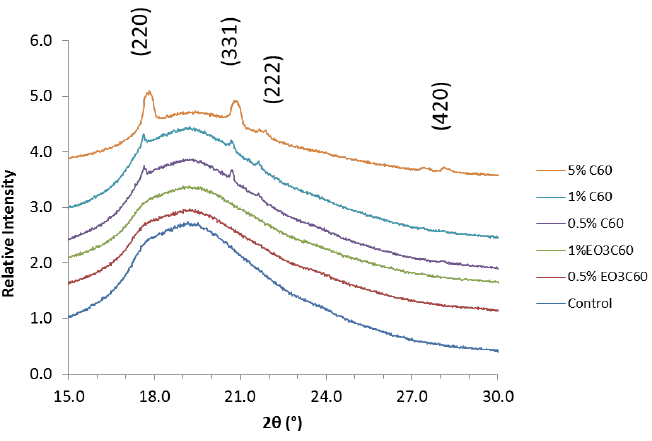
Figure 4. XRD patterns of Tecoflex films containing